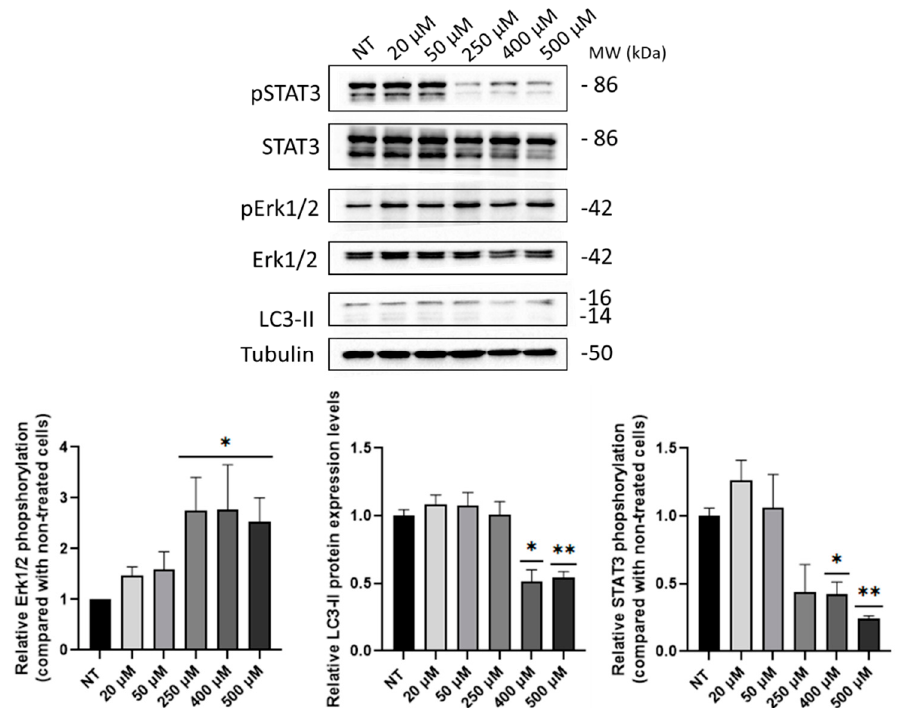
Figure 8. Phospho-Erk1/2, LC3-II, and phospho-STAT3 levels in Caco-2 cells at 4 h p.t. after B5 administration at increasing concentrations (i.e., 20, 50, 250, 400 and 500 µ M). Phosphorylated proteins were normalized to the total proteins and housekeeping levels. Normalized values are reported on Y -axis as arbitrary units. Molecular weights (MW) in kDa and SEM bars are shown. Asterisks indicated p < 0.05 (*) or p < 0.01 (**), compared with non-treated (NT) control cells (ANOVA One-Way). The experiments were performed on three independent biological replicas.